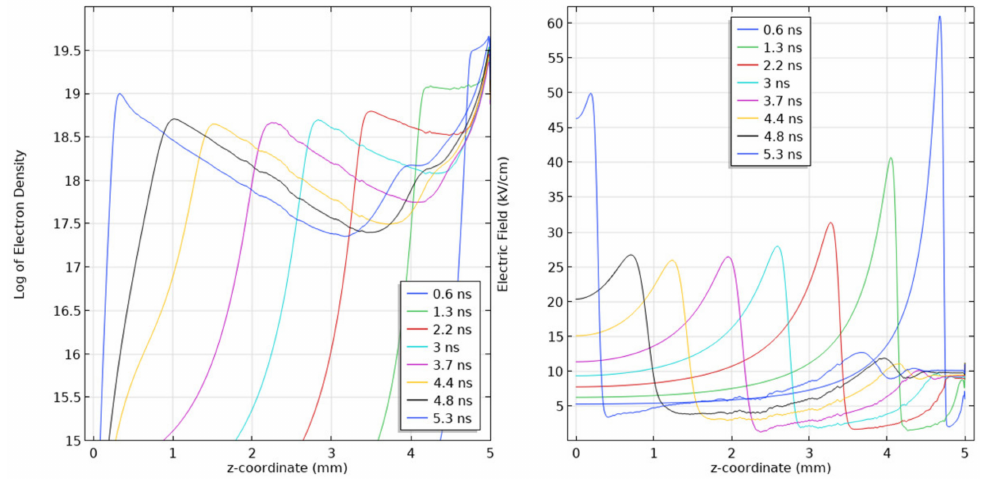
Figure 14. Line diagrams along the symmetry axis of the log of the Electron Density profile ( left ) and its corresponding Electric Field distribution ( right ) for a streamer propagating in a 5 mm SF 6 gap at a pressure of 10 kPa. Applied voltage of 5 kV. Scaling parameter for density profiles: 20 on logarithmic plot represents a density value of 10 20 m − 3